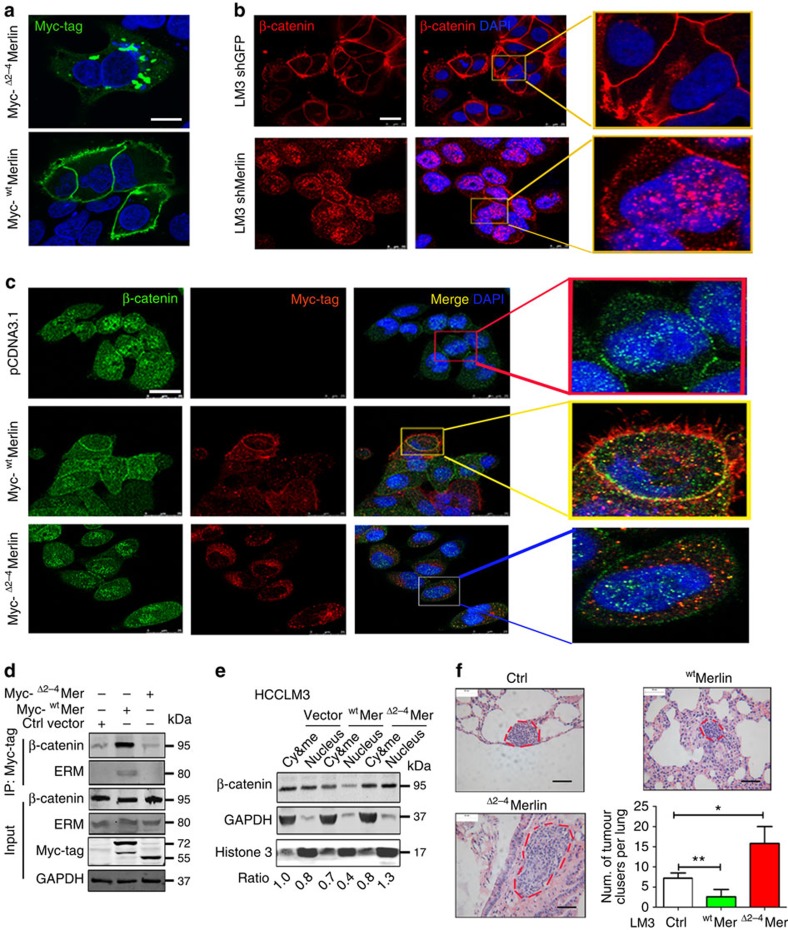
Δ2–4Merlin loses its functions of anchoring the membrane and binding to ERM and β-catenin.(a) Myc-tagged wtMer or Myc-tagged Δ2–4Mer was expressed in HCCLM3 cells, and an anti-Myc antibody was used for immunofluorescence staining. (Scale bar, 20 μm). (b) Immunofluorescence analysis of β-catenin in HCCLM3 cells expressing shMerlin. DAPI was used for nuclear staining. Scale bar, 20 μm; Magnification for small square: × 400) (c) Confocal analysis for wtMer and Δ2-4Mer in HCCLM3 cells. Myc-tagged wtMer or myc-tagged Δ2-4Mer was expressed in HCCLM3 cells. The cells were stained with antibodies for β-catenin or Myc-tag. The nuclei were stained with DAPI. (Scale bar, 20 μm; Magnification for small square: × 400). (d) Immunoprecipitation assay for wtMer or Δ2–4Mer with ERM and β-catenin. (e) The fractionation of wtMer and Δ2–4Mer expressing HCCLM3 cells was performed and analysed by immunoblotting for β-catenin expression with the indicated antibodies. (f) Δ2-4Mer- or wtMer-expressing HCCLM3 cells were injected into the caudal veins of BALB/C nude mice. The lung metastatic tumours were stained by H&E; Scale bar, 100 μm. The tumour numbers were counted and are shown to the right of the graphs (five mice per group). *P<0.05; **P<0.01, based on the student's t-test.